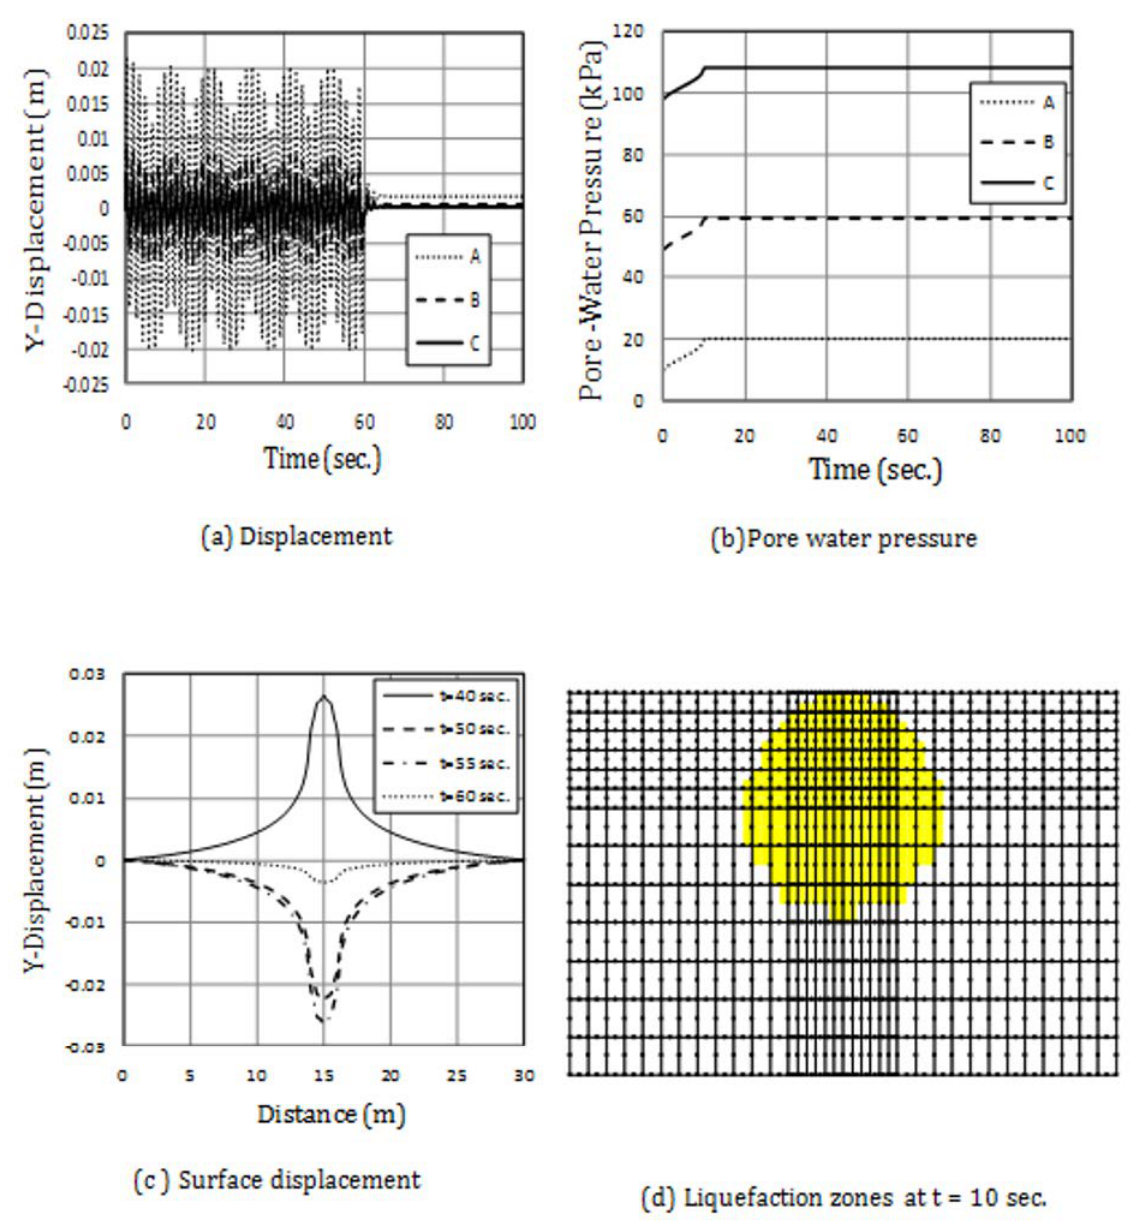
Figure 7. Dynamic response of the foundation to harmonic load, a